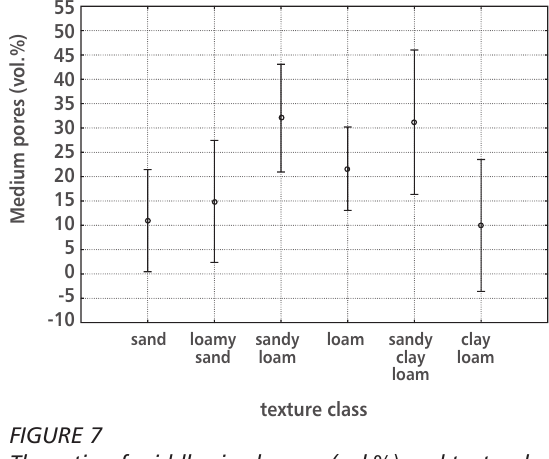
The ratio of middle-sized pores (vol.%) and textural classes of